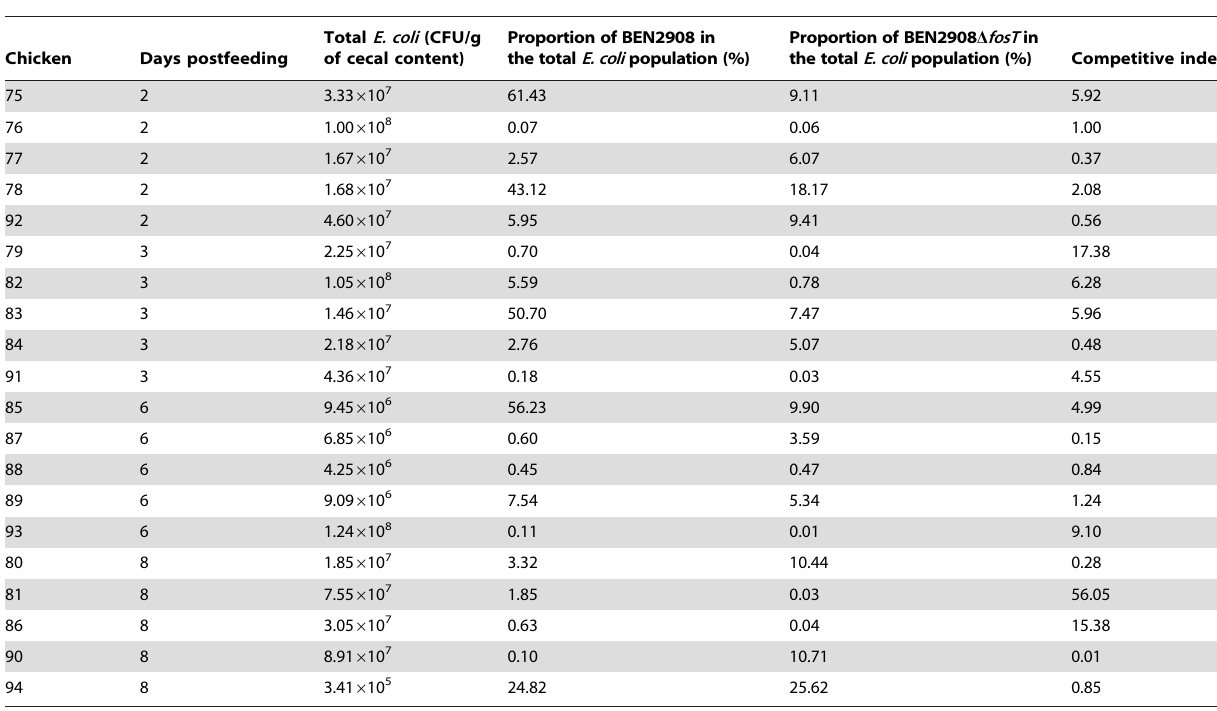
Table 2. Proportion of the BEN2908 and BEN2908 D fosT strains in the total E. coli population in the cecal content of each SPF